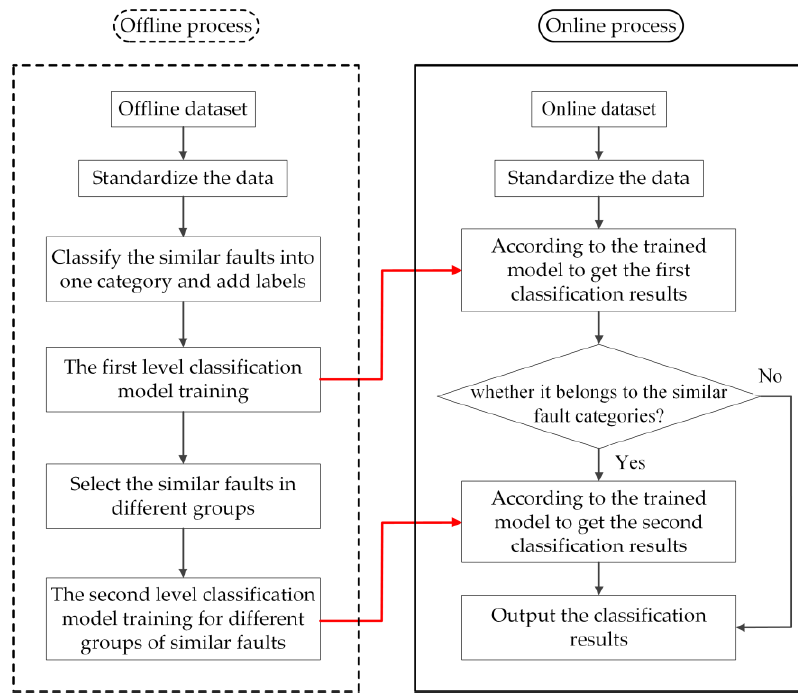
Figure 8. Flowchart of the proposed fault diagnosis strategy.